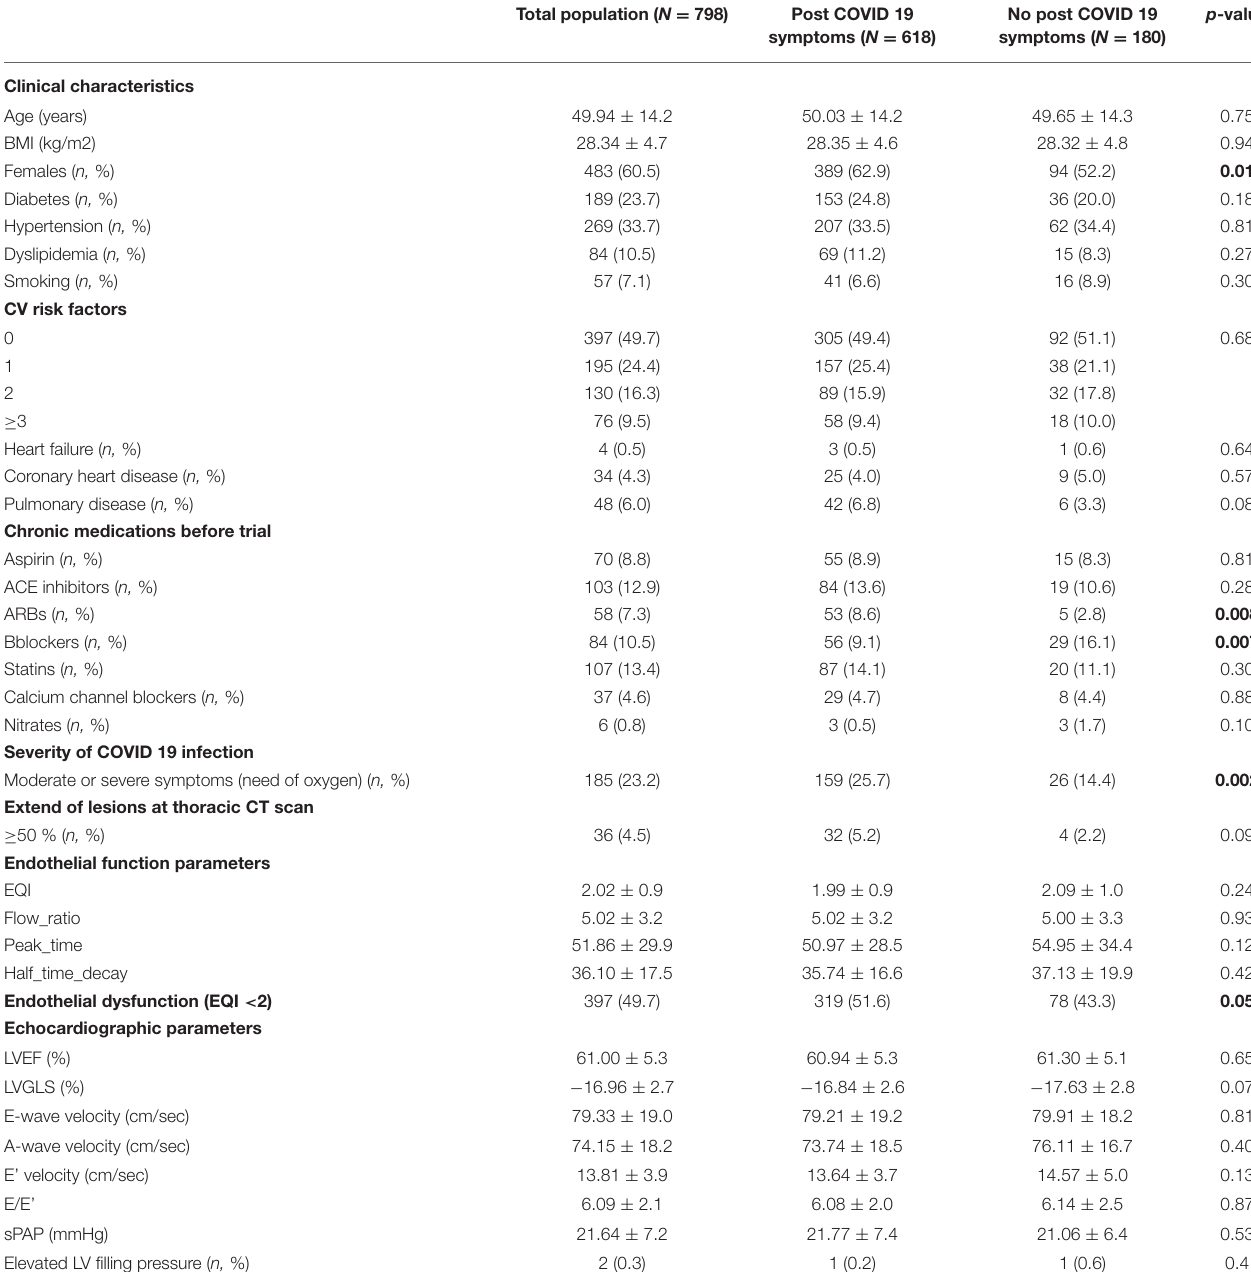
TABLE 1 | Baseline characteristics of the study